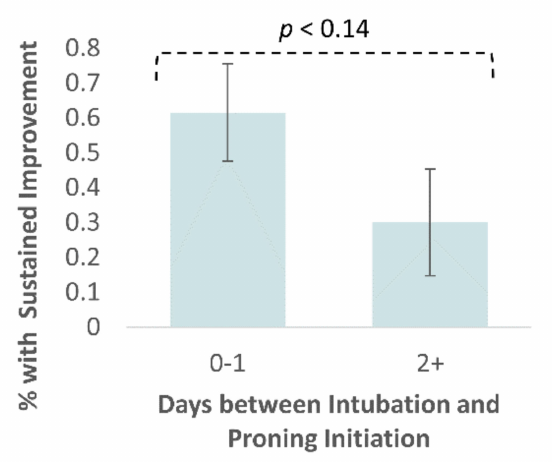
Figure 3. Sustained improvement in PaO 2 / FiO 2 by days between intubation and proning initiation. Sustained improvement was defined as a ≥ 10% improvement in PaO 2 / FiO 2 between pre-proning measurement and measurement 48 h after proning initiation. Patients were segmented by the timing of proning initiation relative to the timing of intubation. Error bars represent the S.E. of the mean. Statistical significance is given by the χ -squared contingency test with α =